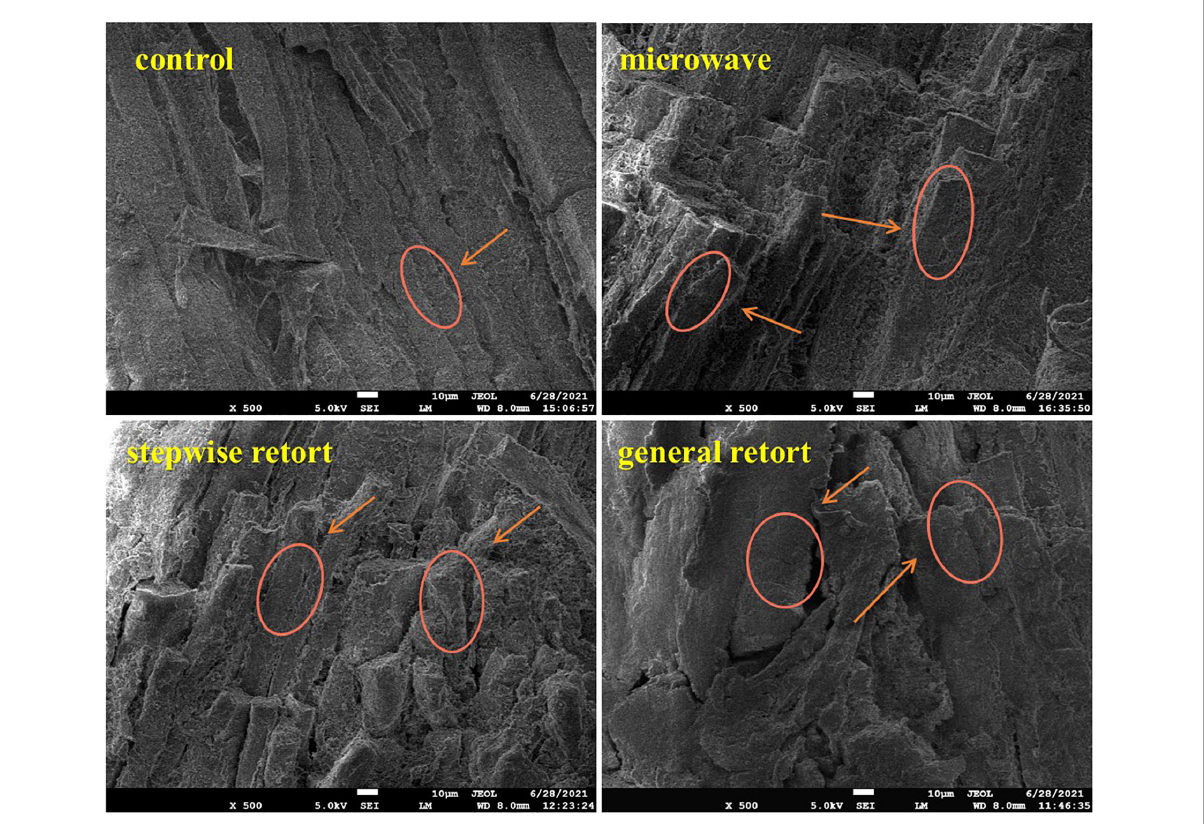
FIGURE3 Scanning electron microscopy images of duck meat treated with no thermal sterilization and three sterilization strategies. The circles and arrows indicate the muscle bundle structure of duck meat with different treatments (magnification, 500 ×